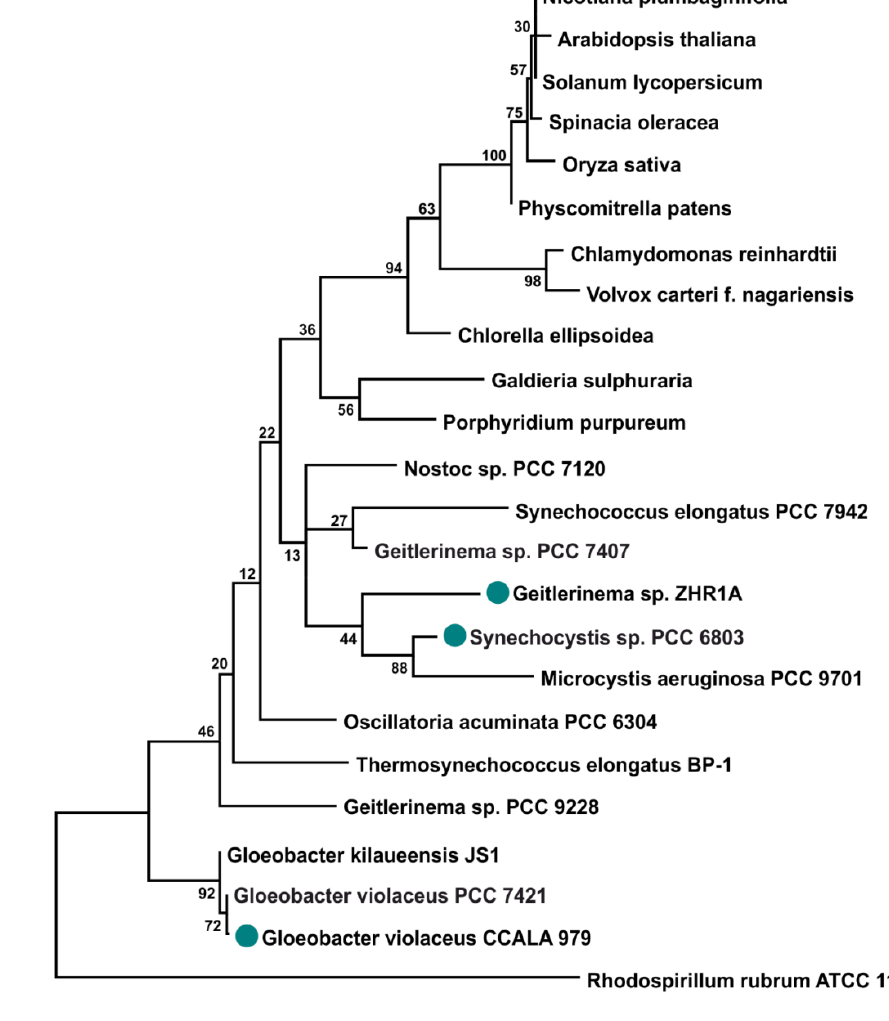
Figure 1. The 16S rRNA tree reconstructed for selected phototrophs performing oxygenic photosynthesis. The tree is rooted with 16S rRNA from Rhodospirillum rubrum . Blue-green circles denote cyanobacteria analyzed here, i.e., Synechocystis sp. PCC 6803, Gloeobacter violaceus CCALA 979 and Geitlerinema sp. ZHR1A (for details see Materials and Methods and Supplementary Material Notes S2). Numbers at nodes show bootstrap values (based on 500 replicates). The scale represents the expected number of substitutions per nucleotide position.